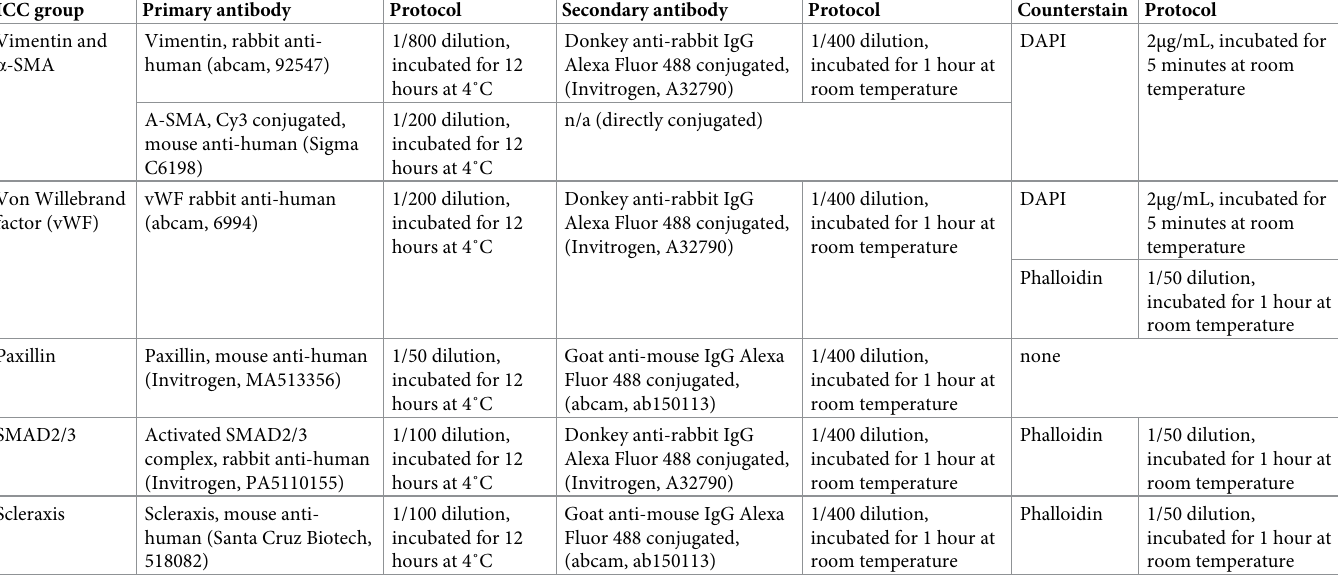
Table 1. Immunocytochemistry (ICC)